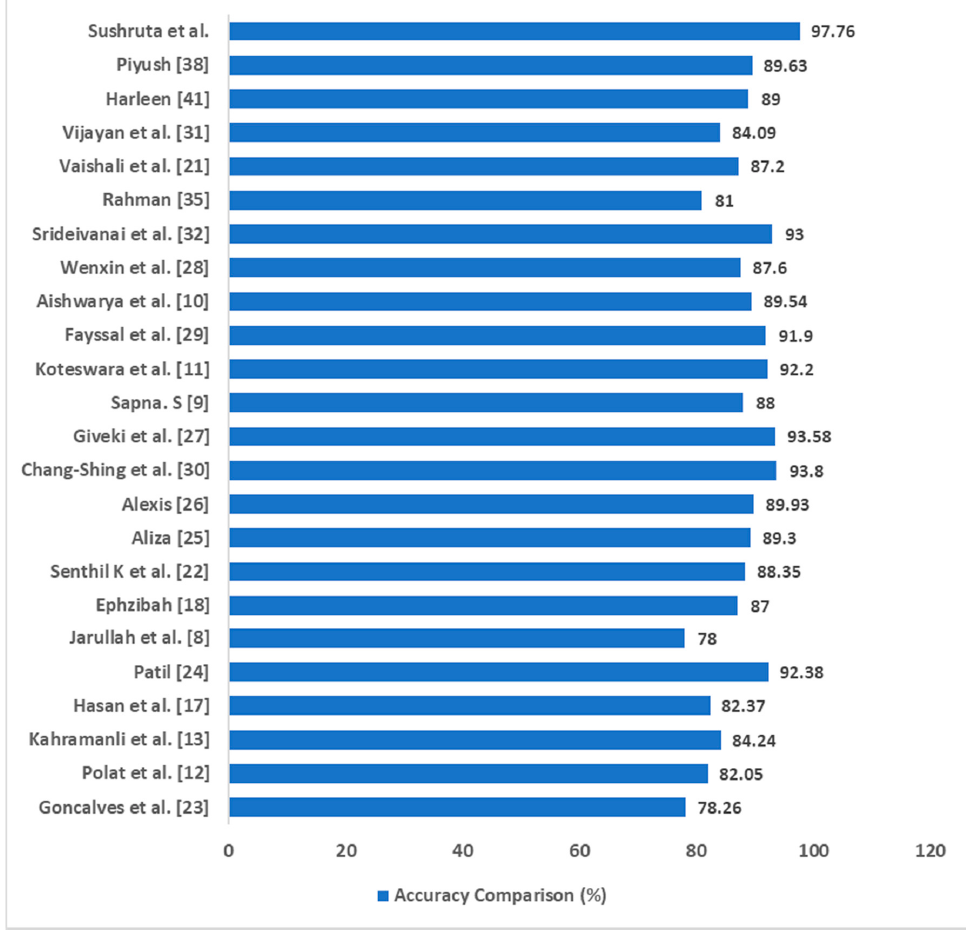
Figure 12. Accuracy comparison of EAGA-MLP model over other literature survey works.